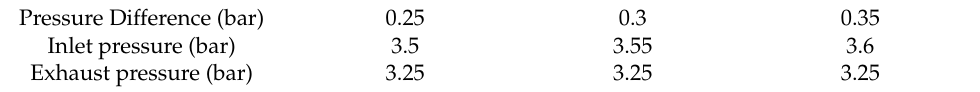
Table 6. The pressure difference resulting from pressure in the scavenging and in the exhaust